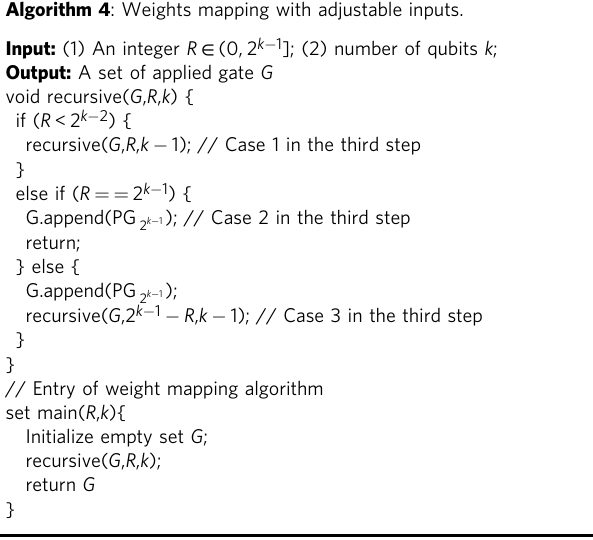
Box 2 | Algorithm in QF-Map Algorithm 4 : Weights mapping with adjustable